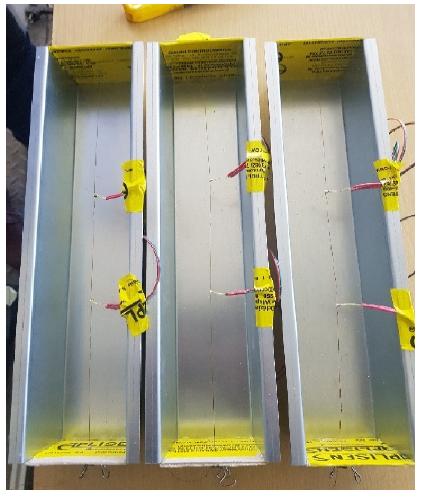
Figure 1. Gypsum molds with embedded